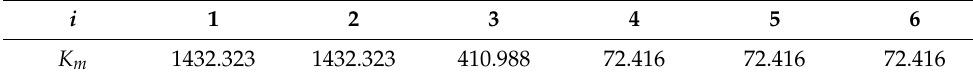
Table 2. The stiffness parameters of the motors. (N · m/rad).